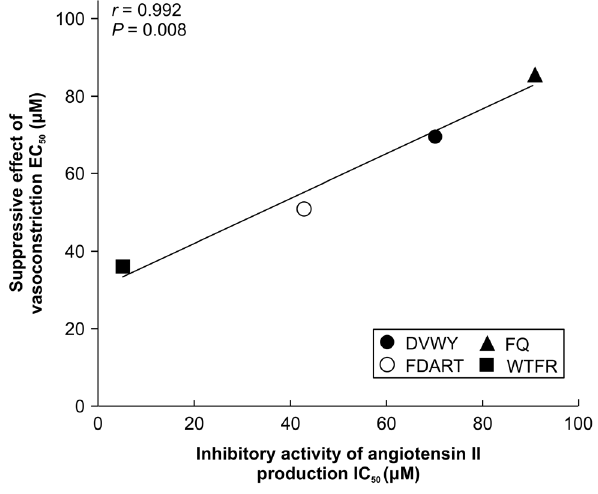
Figure 5. Correlation between suppression of Ang II produc- tion and vasoconstriction by DVWY, FDART, FQ, and WTFR. Correlation analysis of suppressive effects of Ang II production (IC 50 ) and vasoconstriction (EC 50 ). Correlation coefficients ( r ) and two-tailed P values are given in the inserts.